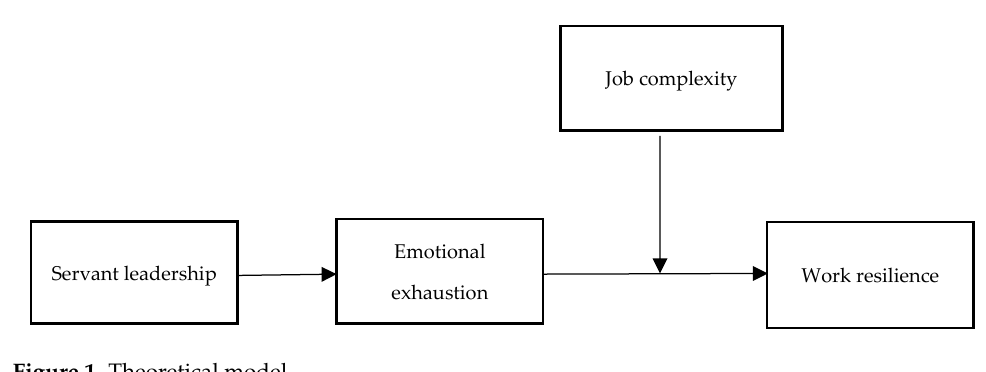
Figure 1. Theoretical model.